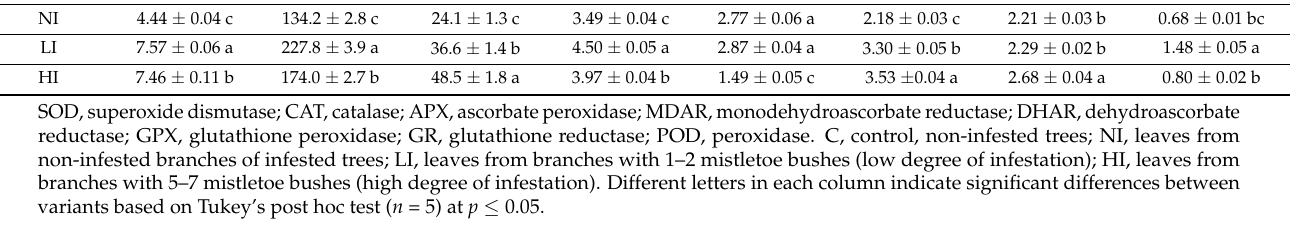
Table 4. Effect of mistletoe infestation on activities of antioxidative enzymes in linden leaves. SOD, Treatment U mg − 1